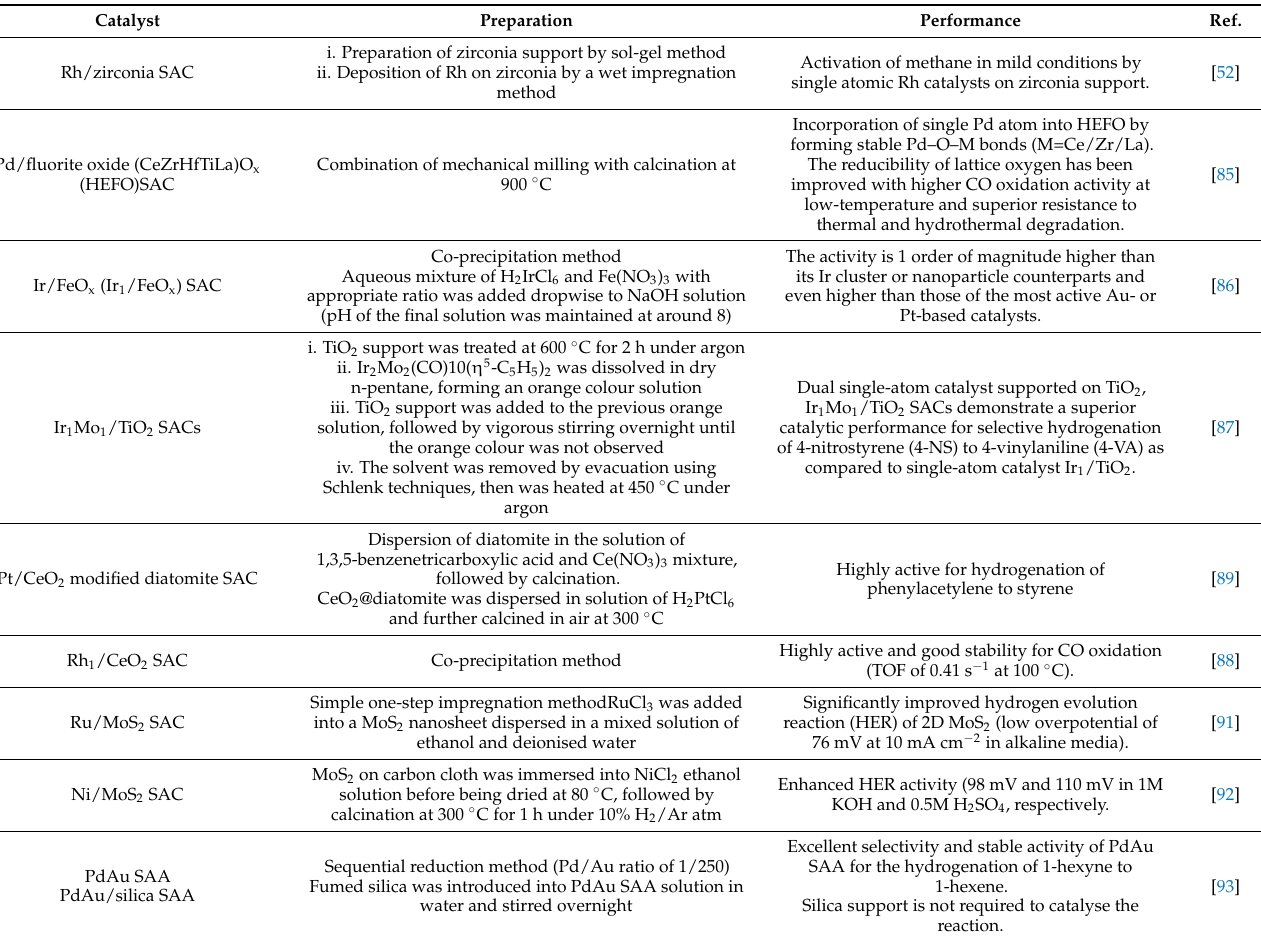
Table 1. Summarisation of supported SACs and